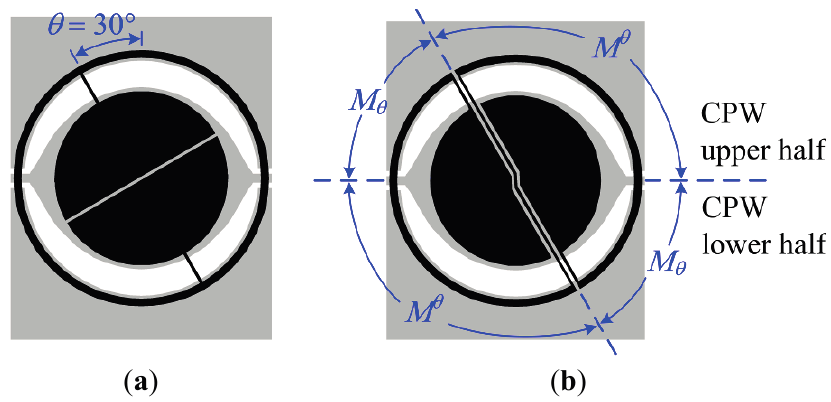
Figure 6. Illustration of resonator topology transformation from ( a ) an ELC resonator [27] to ( b ) an S-SRR. The geometrical division associated to the mutual inductances corresponding to the two CPW halves and the two S-SRR loops is sketched in (b). The substrate is Rogers RO3010 with thickness h = 1.27 mm, relative permittivity ε r = 11.2, and loss tangent tan δ = 0.0023. Dimensions are: for the line, W and G are tapered so that